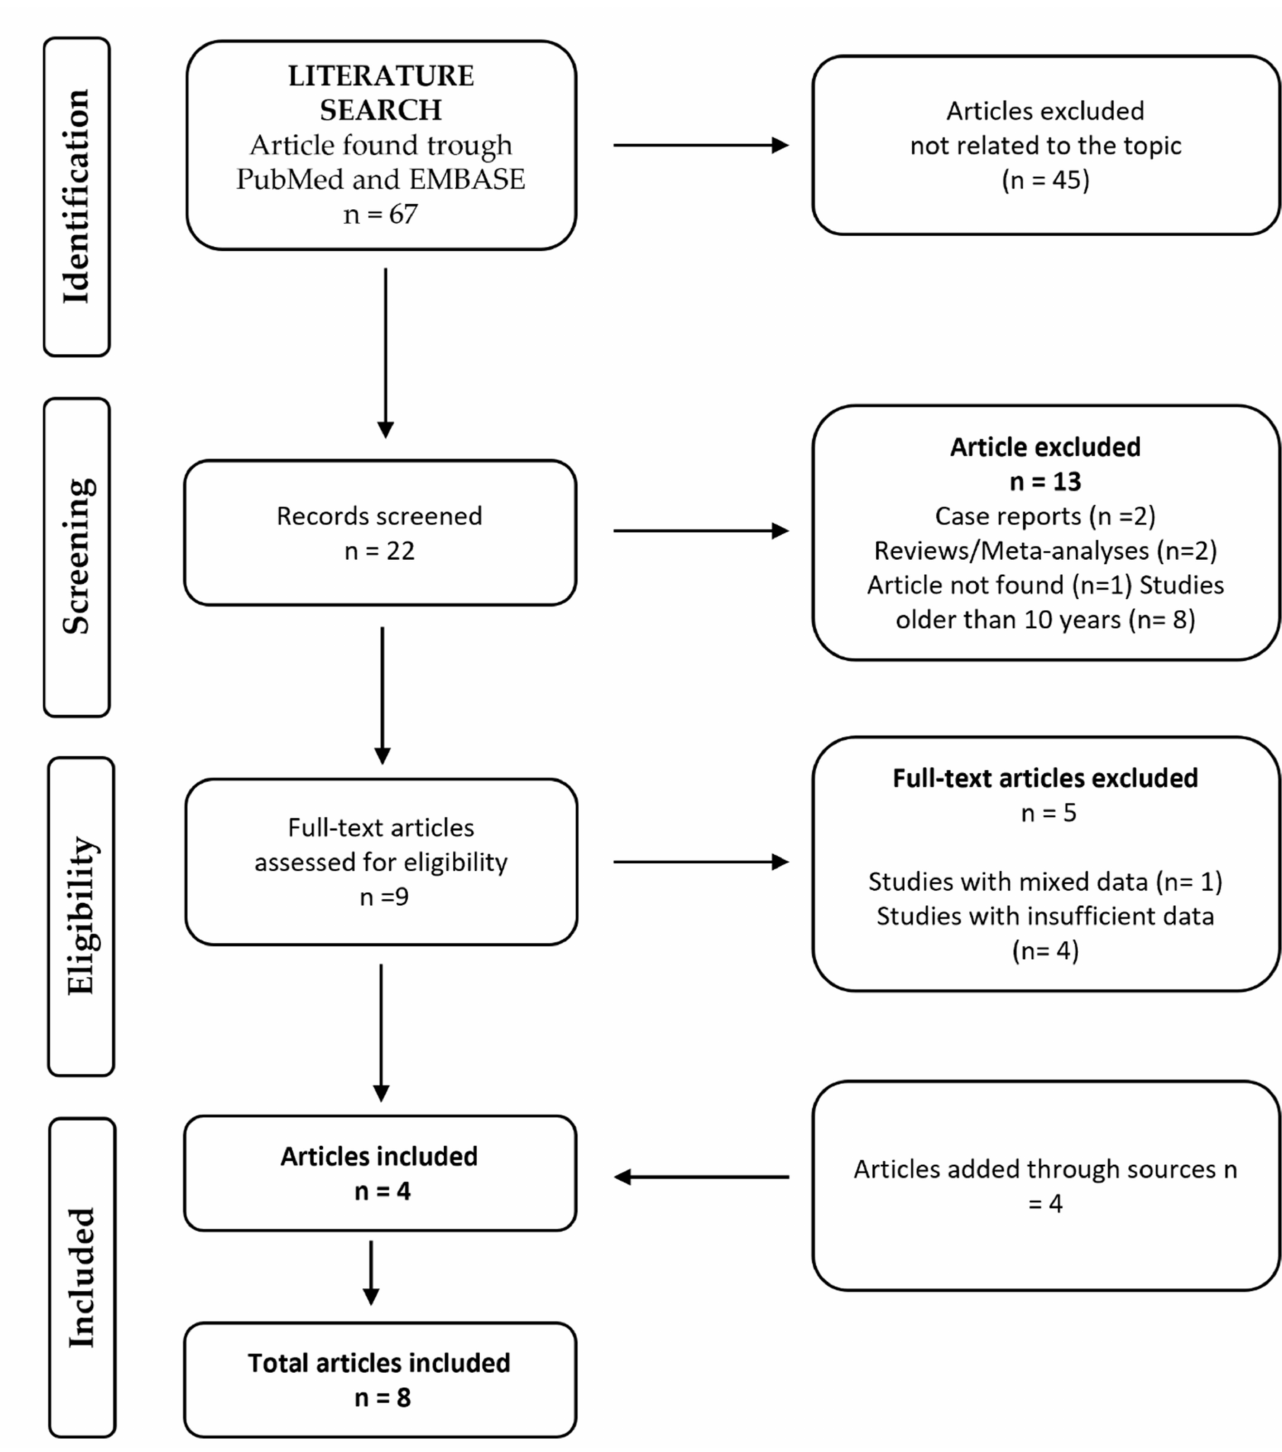
Figure 1. PRISMA flow chart of the selection